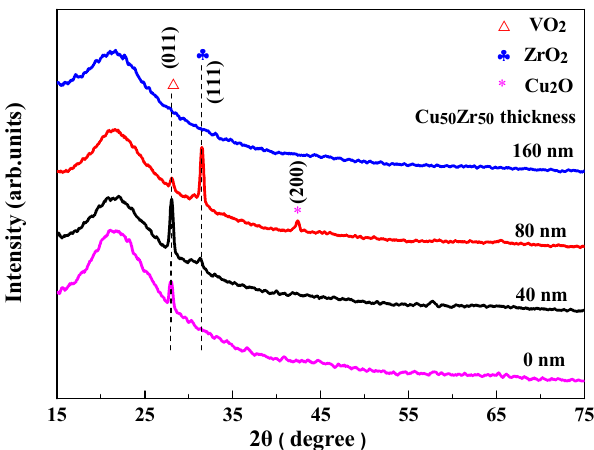
Figure 1. X-ray diffraction (XRD) patterns of vanadium dioxide (VO 2 ) films deposited on Cu 50 Zr 50 buffer layers with different thicknesses.